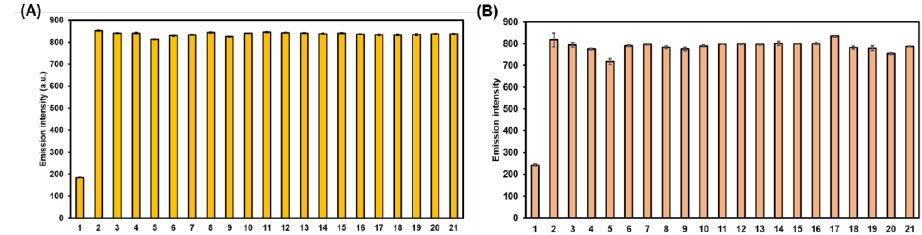
Figure 6. Bar charts demonstrating fluorescence intensities at 512 nm of compounds 2 ( A ) and 3 ( B ) in the presence of HOCl with and without various analytes in MeOH — 5 mM PBS (1:1 v/v). [BOD-